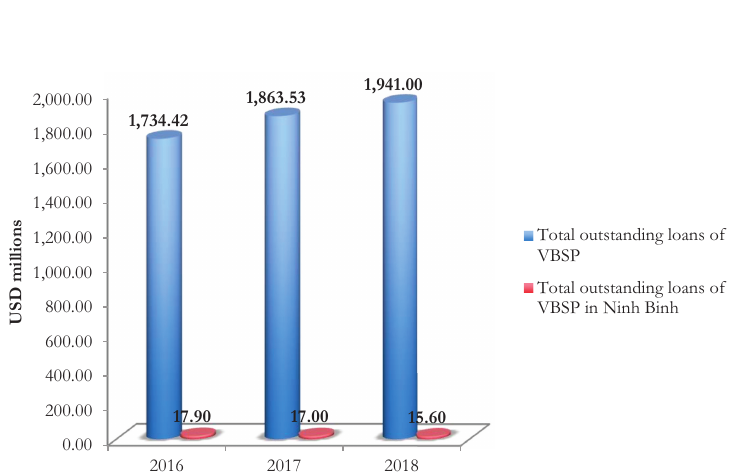
Figure 1. Total outstanding loans of the VBSP and its branch in Ninh